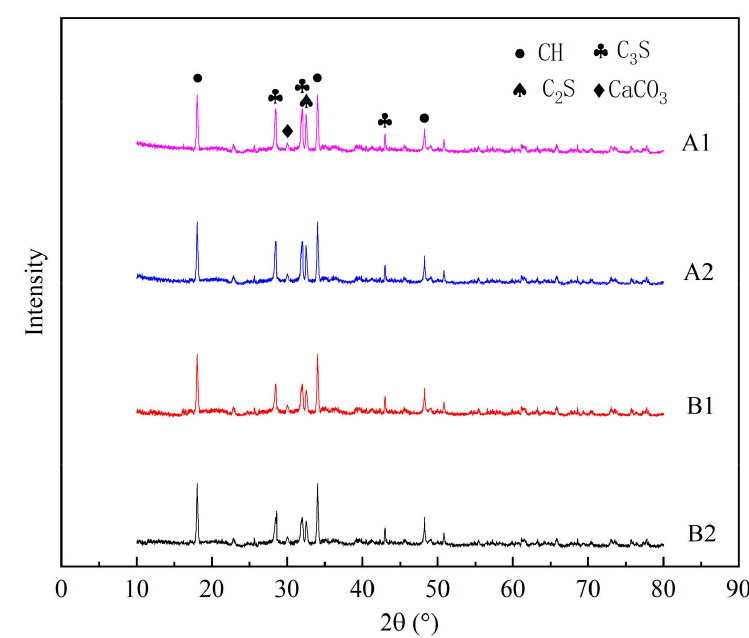
Figure 11. Comparison of XRD phases in concrete